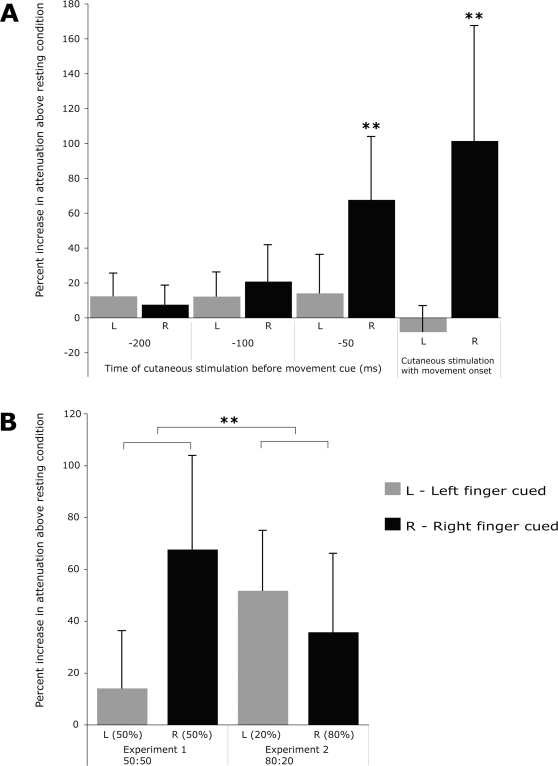
Percent increase above resting condition in the “point of subjective equality” (PSE) for a probe stimulus applied to the right index finger as compared to a reference stimulus to the left little finger.A) shows results from experiment 1 for left (grey bars) and right finger movements (black bars), when stimuli were delivered 200, 100 and 50 ms prior to a cue instructing which finger to move or together with movement onset with equiprobable chance of left and right cues. Asterisks indicate highly significant (p<0.001) changes as compared to the baseline (resting) condition (two-tailed t-tests), which only occurred when the right finger was subsequently cued. B) shows results from experiment 1 (left side) and experiment 2 (right side) in which right cues occurred 4 times more frequently than left cues (“80:20”). A highly significant interaction (ANOVA interaction F1,14 = 17.22, ** = p<0.001) arose because attenuation in the right finger occurred also on rare left-cued trials in the 80:20 group only, suggesting a new expectation-based mechanism of sensorimotor attenuation.